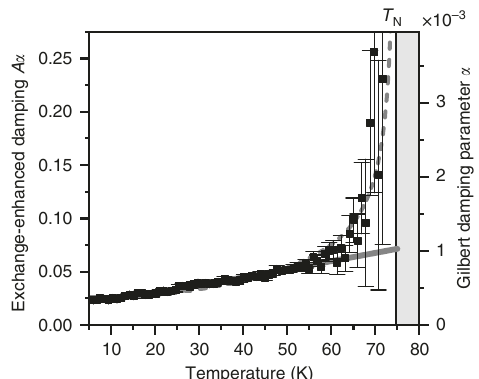
Fig. 5 Temperature-dependent damping of the Z mode in YMnO 3 . Gilbert damping parameter α and exchange-enhanced damping A α are shown in the same plot with A = 69.3 (see Methods section, Table 1). Full line: offset Bose-Einstein distribution with constant quasiparticle energy E = 2.6 meV. Dashed line: offset Bose-Einstein distribution with E ∝ ω 0 and E (0 K) =